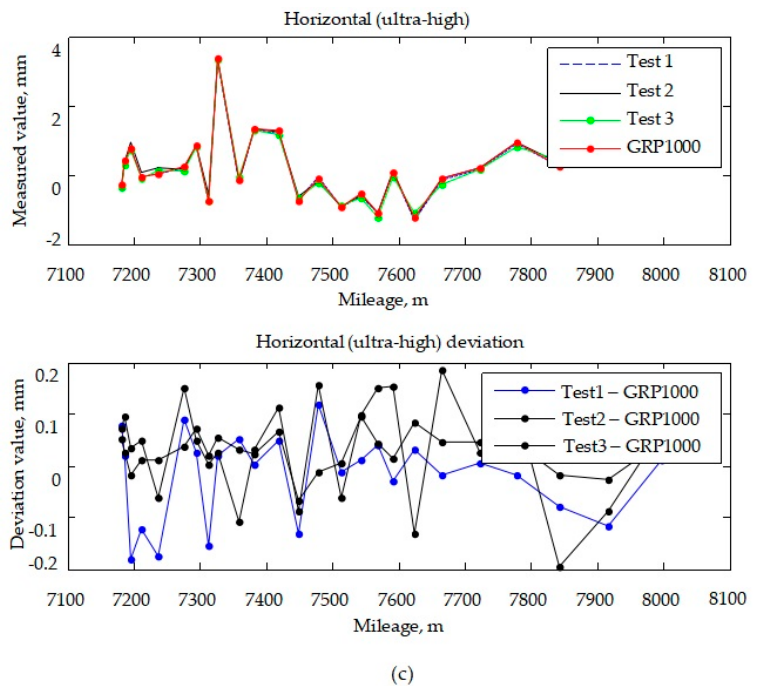
Figure 8. Absolute deviation comparison of three replicates of test data for track geometry parameters of test lines: ( a ) track direction; ( b ) high and low; ( c ) horizontal (ultra-high).